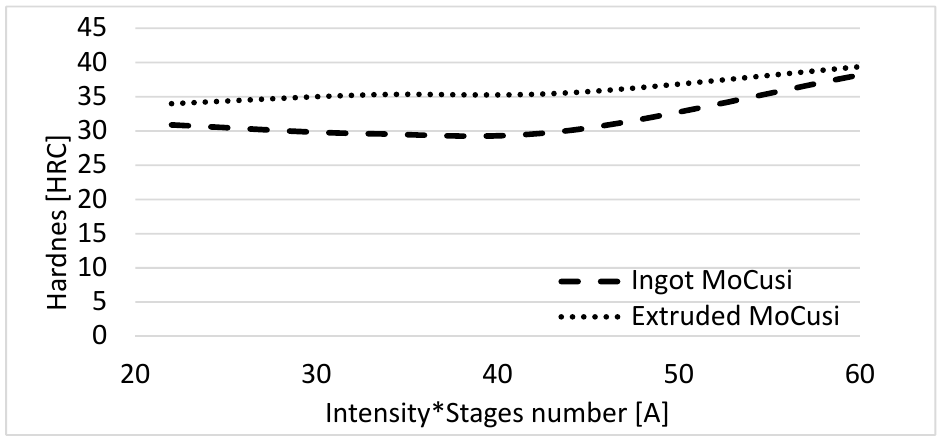
Figure 4. Comparison of hardness/intensity in finishing for both materials.